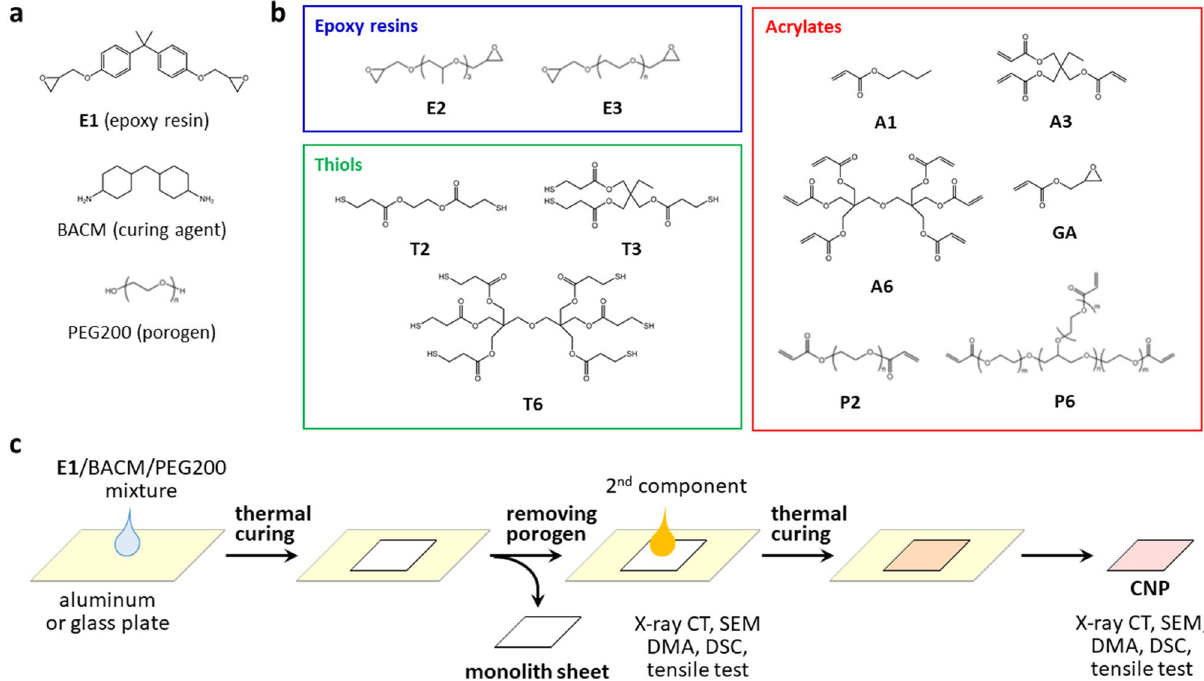
Figure 1. Process for the fabrication of epoxy monolith and CNP. ( a ) Chemical structure of compounds used for the fabrication of epoxy monolith. ( b ) Chemical structure of compounds used as the second component of the CNPs. c, Schematic illustration for the fabrication and characterization of epoxy monolith sheets and the